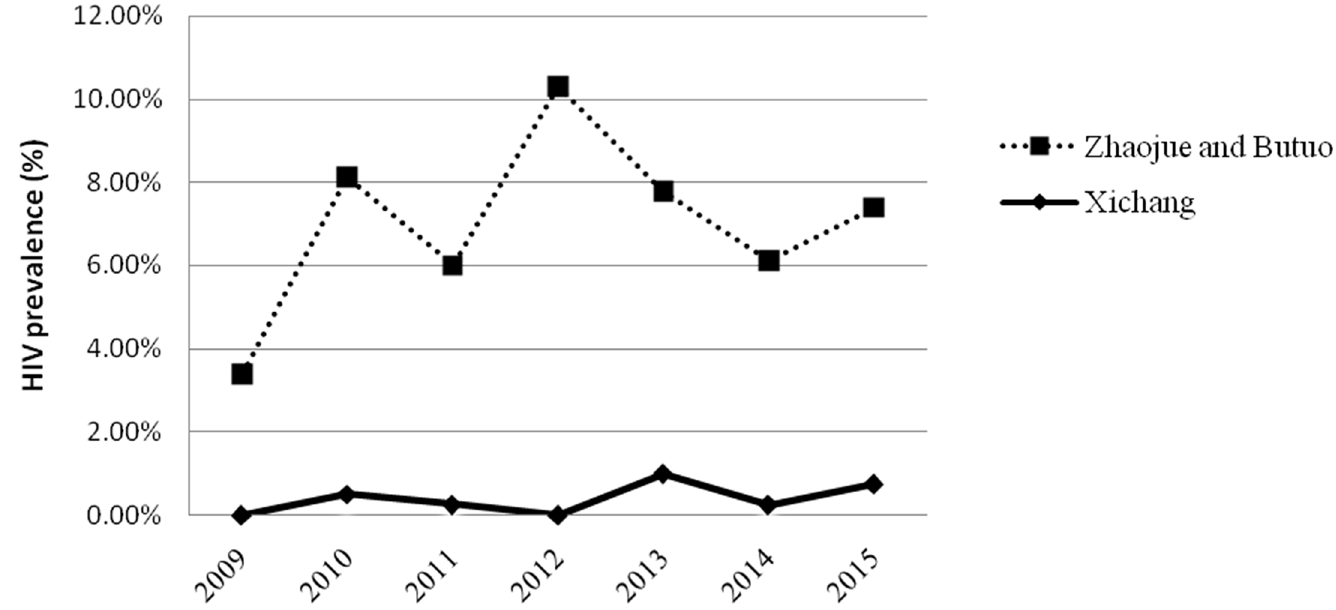
Fig 1. HIV prevalencein pregnant women.